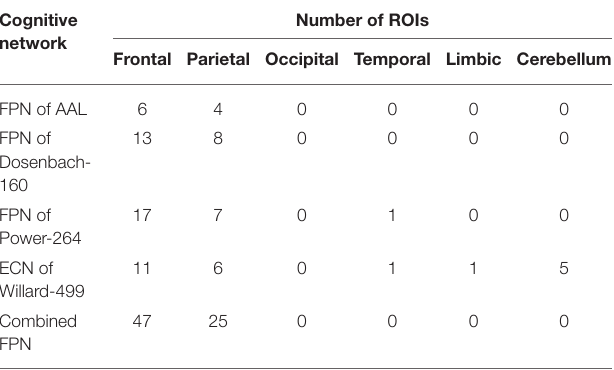
TABLE 2 | Fused fronto-parietal network. Cognitive network Number of ROIs